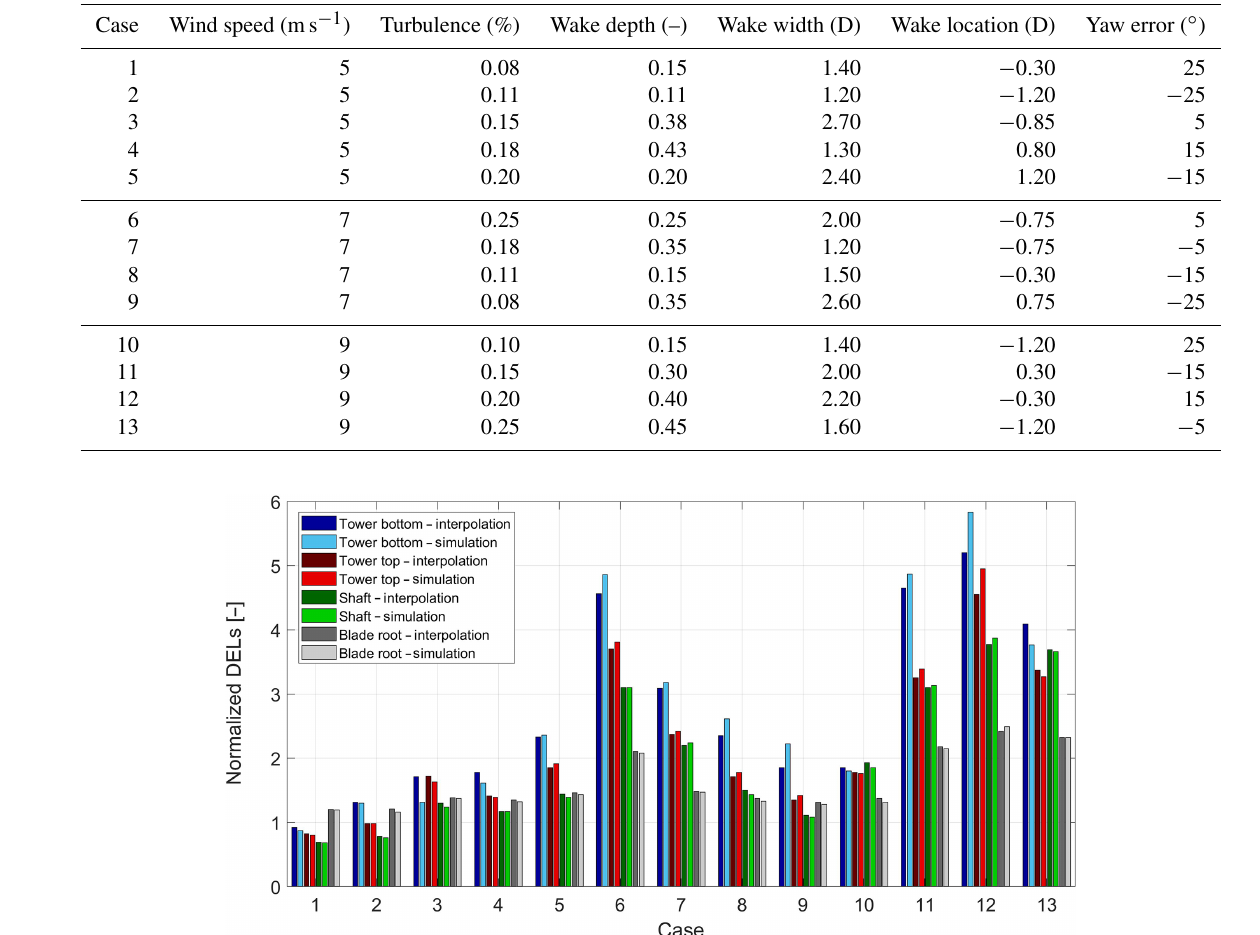
Table 2. Wake parameters for validation of the interpolation properties of the farm modeling approach. Case